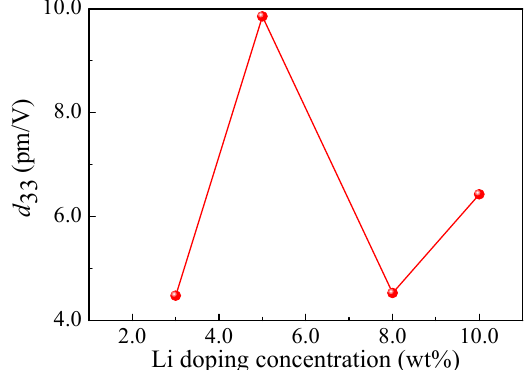
Figure 8. The piezoelectric coefficient d 33 of the LZO thin films under different Li doping